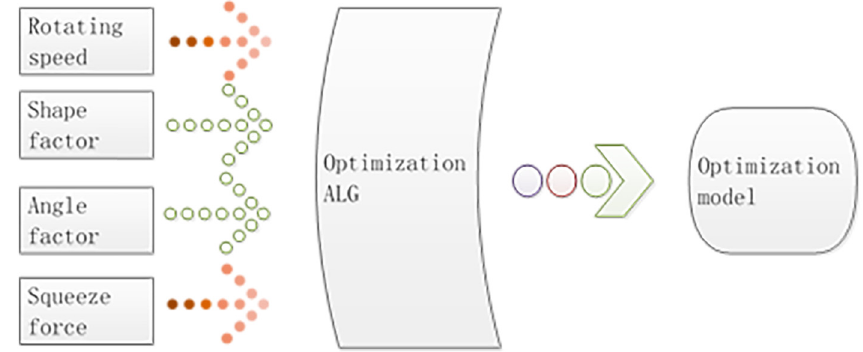
Figure 8: Encapsulated module of the optimization model.